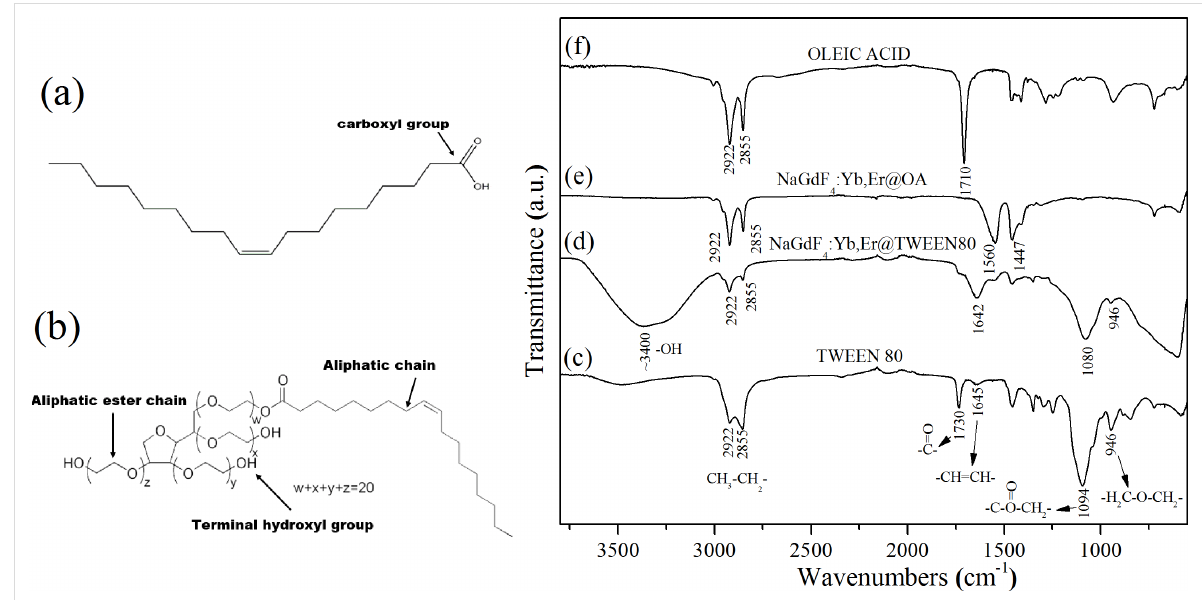
Figure 3: The structure of (a) oleic acid (OA) and (b) Tween 80. FTIR spectra of (c) pure Tween 80, (d) NaGdF 4 :Yb,Er@Tween80, (e) NaGdF 4 :Yb,Er@OA, and (f) pure